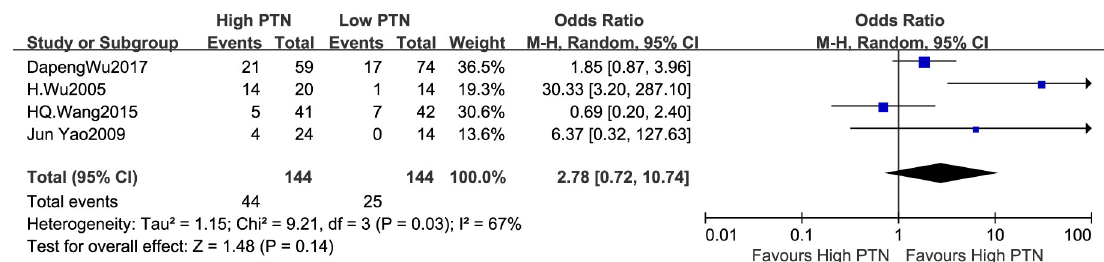
Fig 4. A forest plot for the association between the PTN expression levels with DM. There was not notable difference in the DM incidence between the high PTN and low PTN expression group.